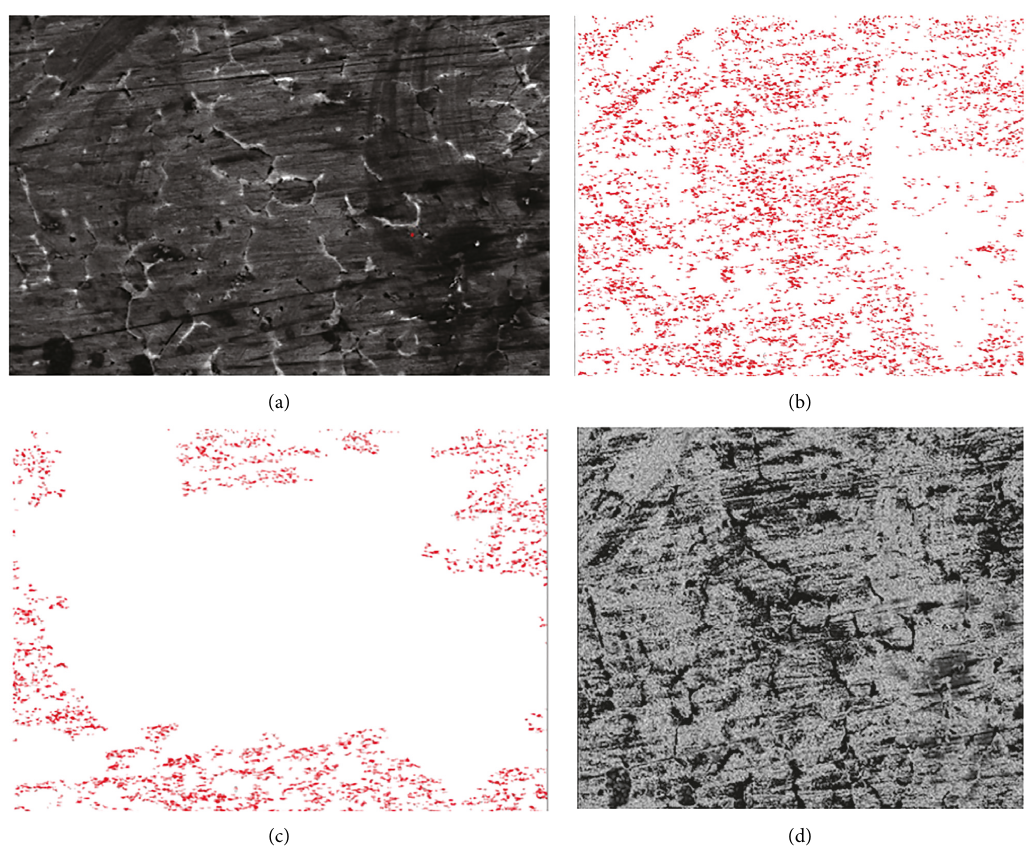
Figure 23: Microstructure analysis at 770 ° c (a) Microstructure at 770 ° c, (b) Nodularity, (c) Porosity, (d) inclusions.